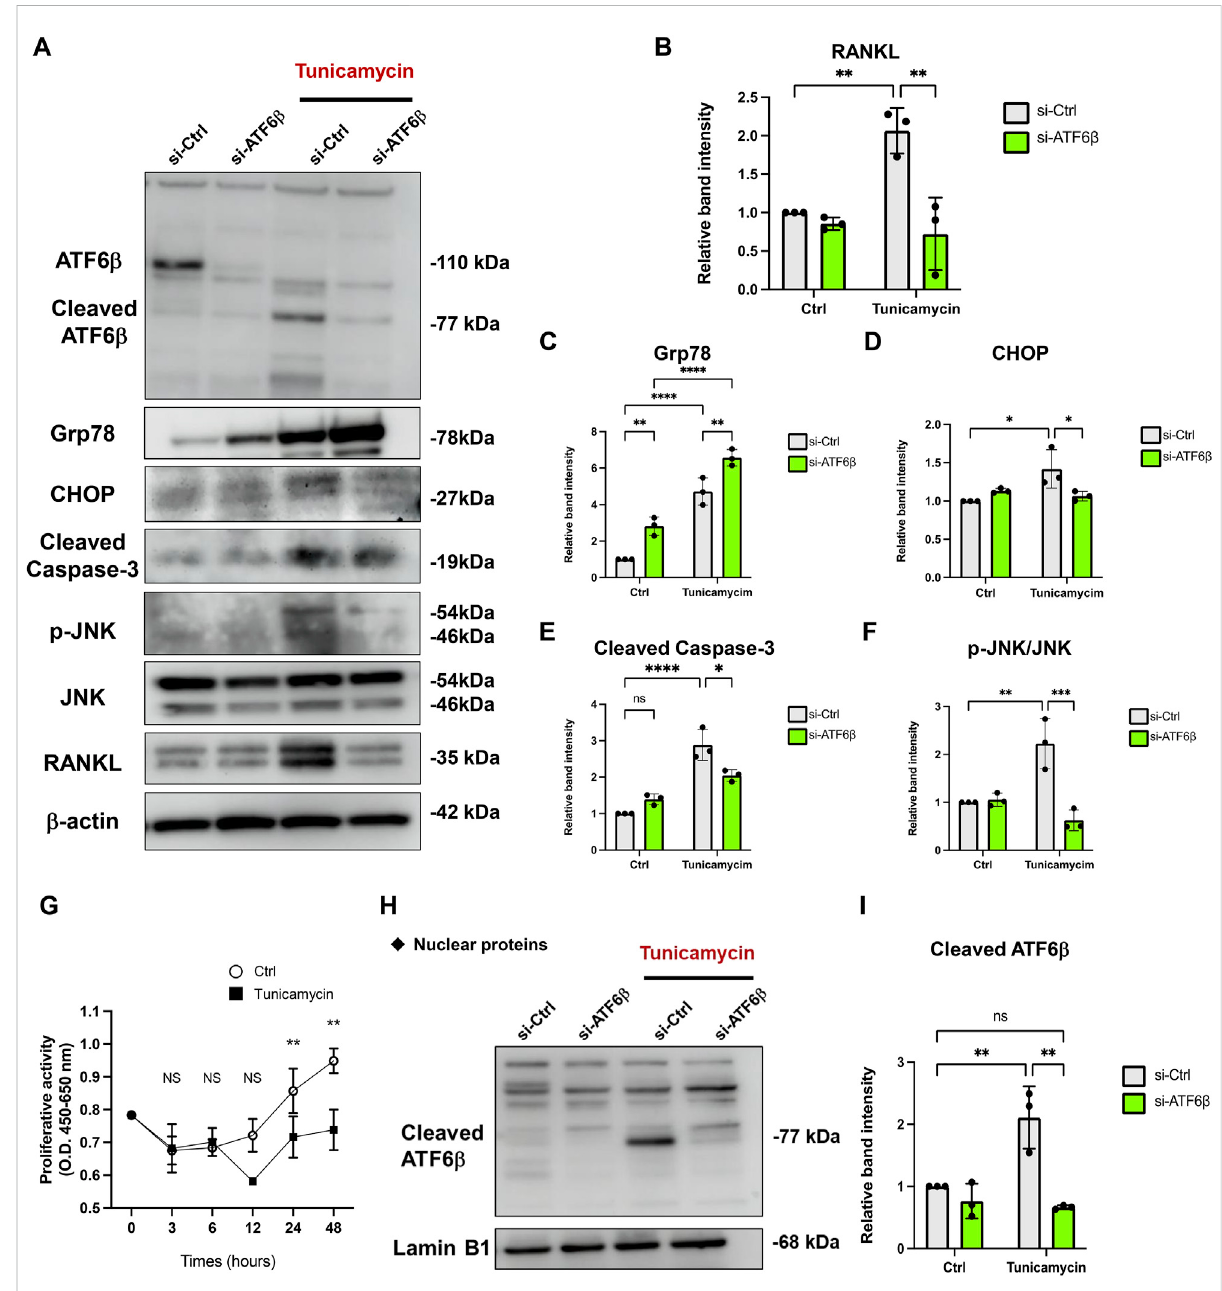
KnockdownofATF6 β suppressestheendoplasmicreticulum(ER)stress-inducedRANKLexpressioninperiodontalligament(PDL)cells.Effectof ATF6 β -siRNA on the expression of RANKL under ER stress. PDL cells were transfected with si-Ctrl or si-ATF6 β for 24 h. After changing the medium, cells were stimulated with 0.5 μ g/ml of tunicamycin for 24 h (A – F) Western blotting analysis revealed the expression levels of full-length/cleaved ATF6 β ,Grp78,CHOP,CleavedCaspase-3,phospho-JNK(p-JNK),JNKandRANKLinPDLcellsandtherelativeexpressionwasmeasured( n =3). β -actin was used as the control. (G) The effect of 0.5 μ g/ml of tunicamycin on proliferation of PDL cells was measured using a WST-8 assay. Proliferationwasmeasuredattheindicatedtimepoints(shownintheX-axis)andexpressedas(absorbanceat450 nm) — (absorbanceat655 nm)( n = 3). (H,I) Nuclear fraction proteins were isolated to analyze the expression of nuclear translocated cleaved-ATF6 β and the relative expression was measured( n =3).LaminB1wasusedasthecontrolfornuclearprotein.ns,notsigni fi cant,** p < 0.01.Thesigni fi